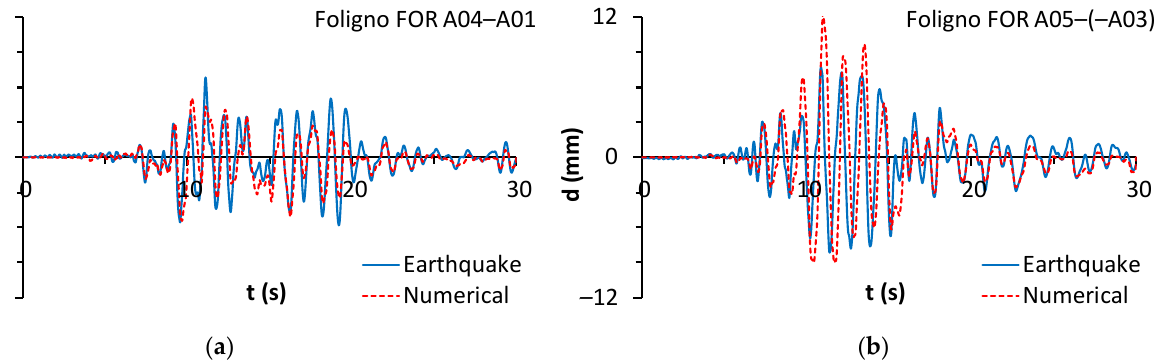
Figure 21. Comparison between the earthquake and numerical accelerations ( a ) in x direction and ( b ) in y direction.